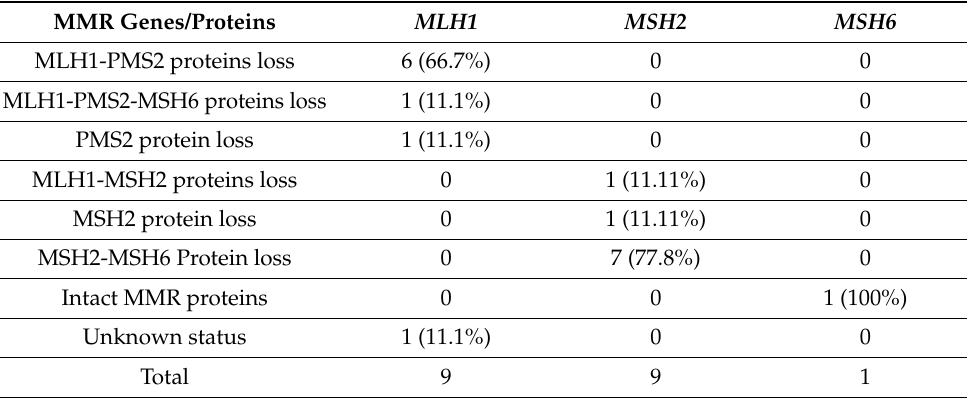
Table 7. MMR genes ( MLH1 , MSH2 , and MSH6 ) with corresponding protein loss by IHC. MMR Genes/Proteins